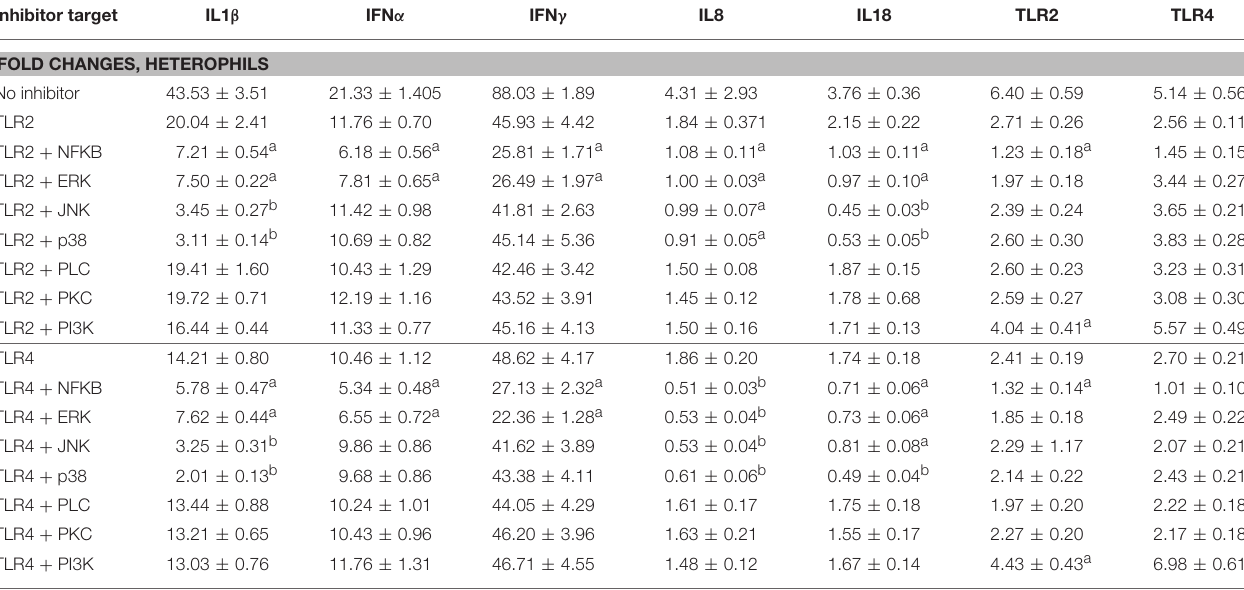
TABLE 5 | TLR2 and TLR4 pathways regulate transcription in heterophils through common intracytoplasmic mediators. Inhibitor target IL1 β IFN α IFN γ IL8 IL18 FOLD CHANGES,